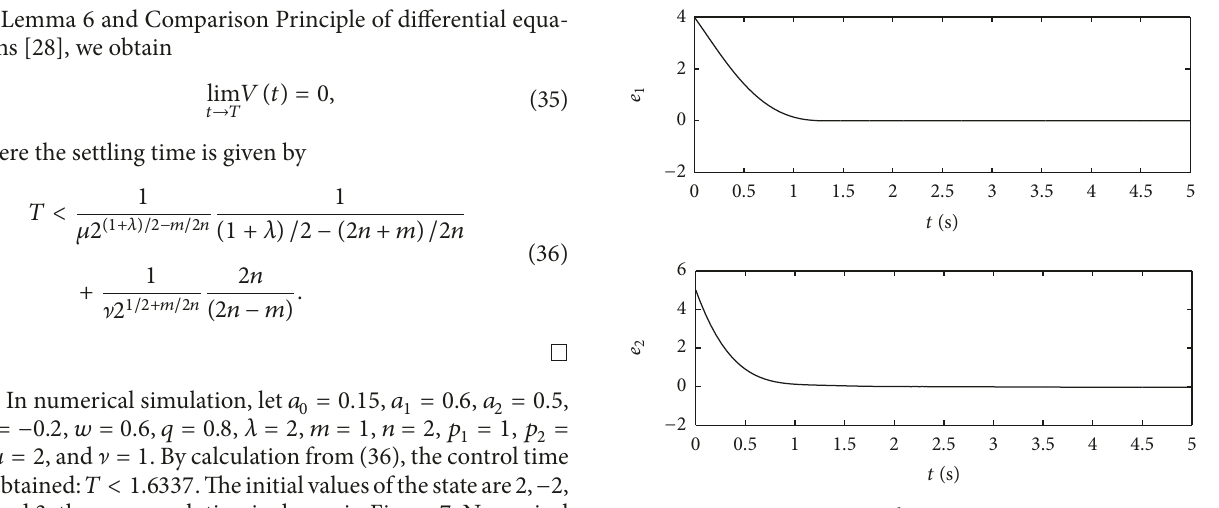
Figure 7: Synchronization